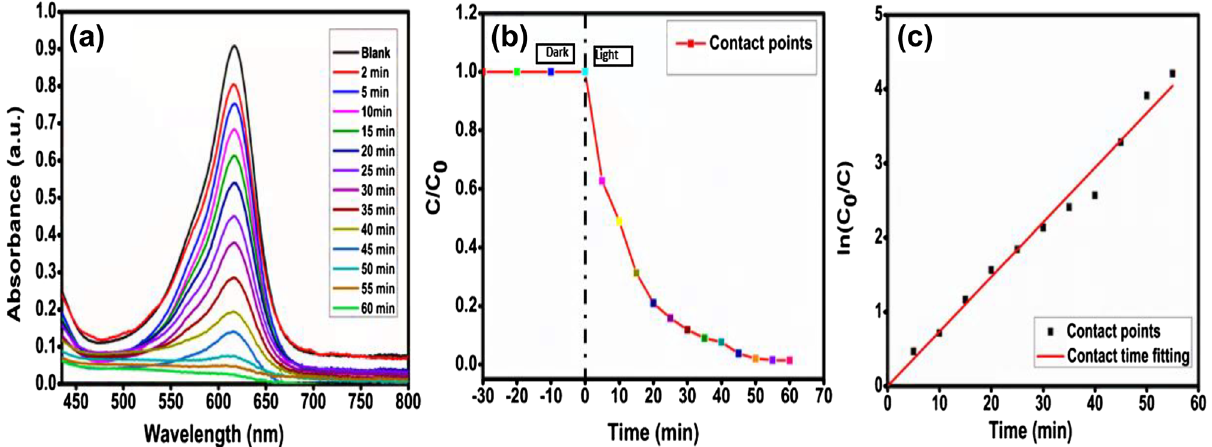
Figure 12. ( a ) Contact time degradation profile, ( b ) Degradation profile, and ( c ) kinetics plot for MG dye degradation at a different time interval.